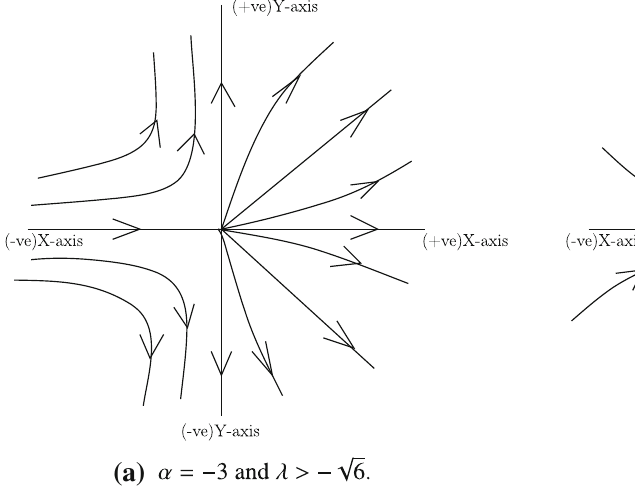
−√ 6 −√ 6 at a time as all